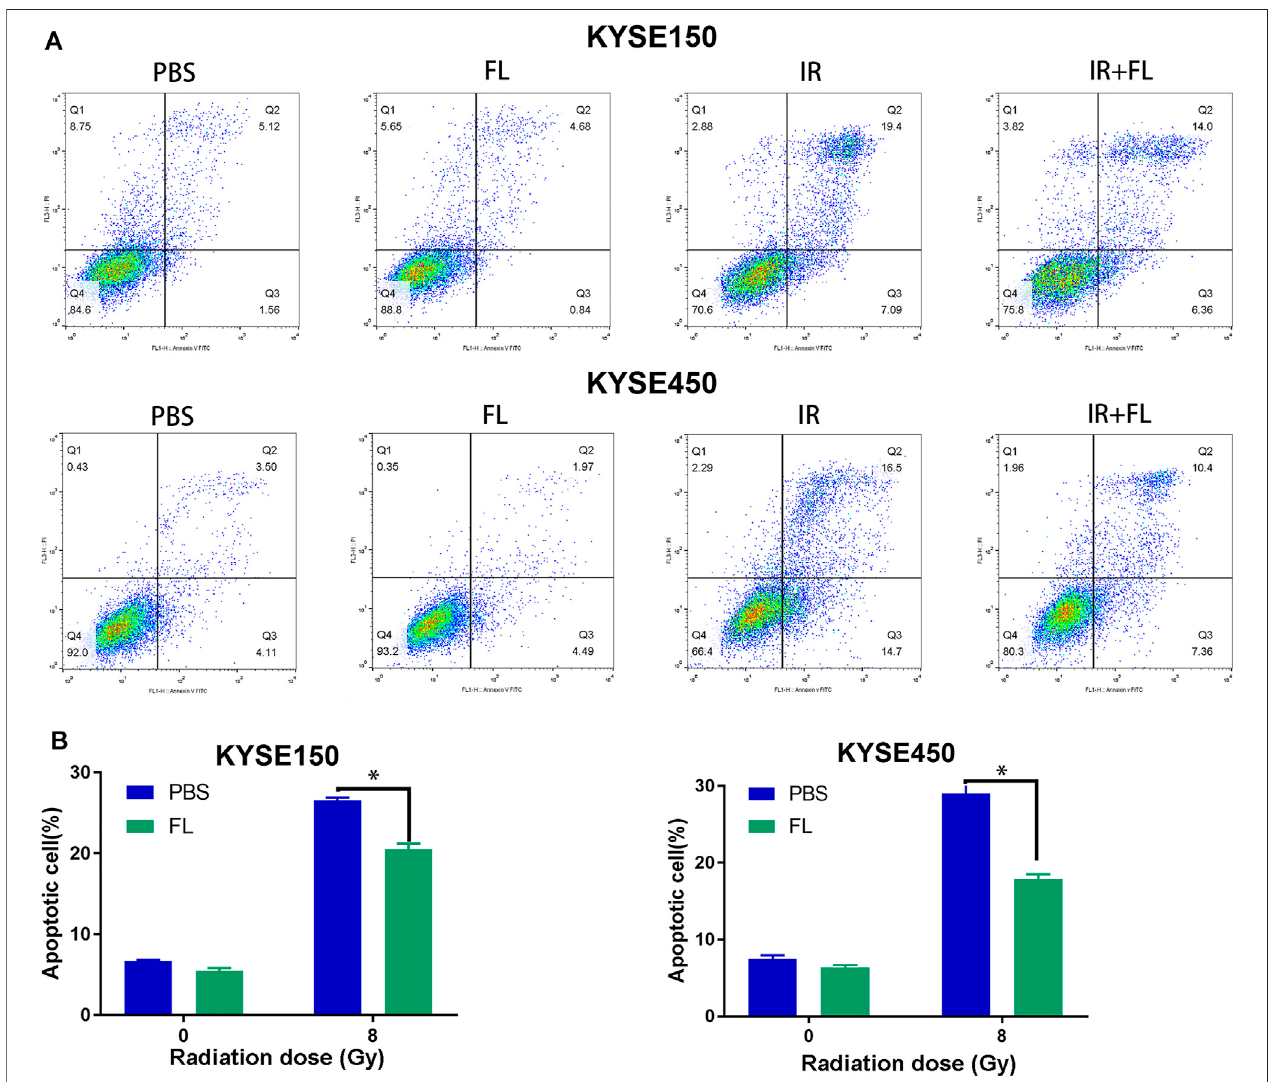
FIGURE 4 | FL decreases IR-induced apoptosis. (A,B) Apoptosis ratio in PBS groups or 200 ng/ml FL administration for 24 h groups after 24 h of 8 Gy radiation. Mean ± SEM, N (cid:2) 3, * p < 0.05.